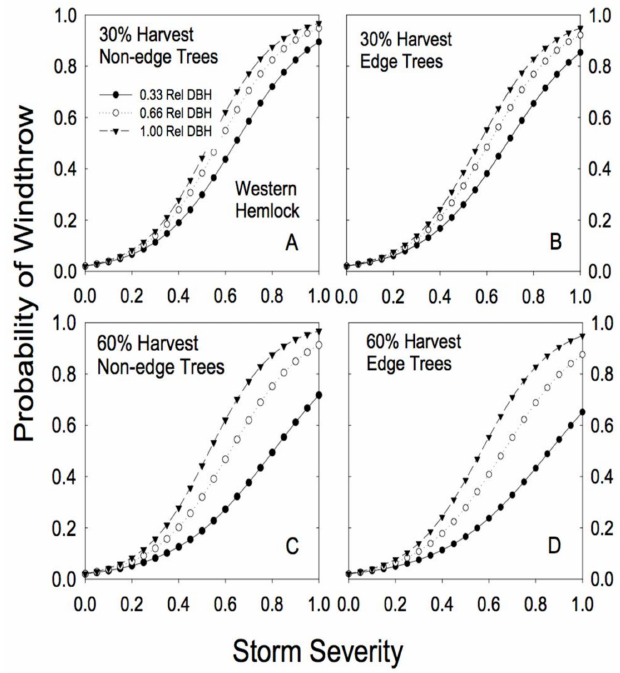
Figure 4. Predicted susceptibility to windthrow as a function of relative tree size and proximity to a forest edge for western hemlock. The predictions were generated from Model 4a, using the parameters reported in Table 2, for two different levels of prior harvest (30% and 60% basal area removal) and for 3 different relative tree sizes (0.33, 0.66, and 1.00 relative DBH). ( A ) For non-edge trees in a plot with a 30% harvest; ( B ) edge trees in a plot with a 30% harvest; ( C ) non-edge trees in a plot with a 60% harvest; ( D ) edge trees in a plot with a 60% harvest.